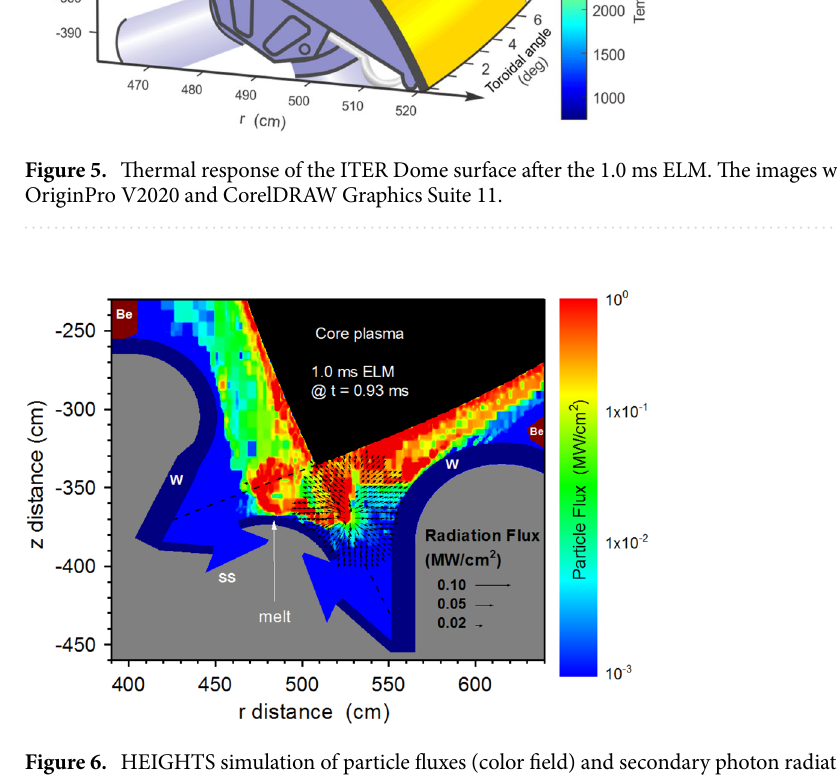
Figure 6. HEIGHTS simulation of particle fluxes (color field) and secondary photon radiation (vectors) in ITER divertor space at t = 0.65 ms of the 1.0 ms ELM. The images were prepared using OriginPro